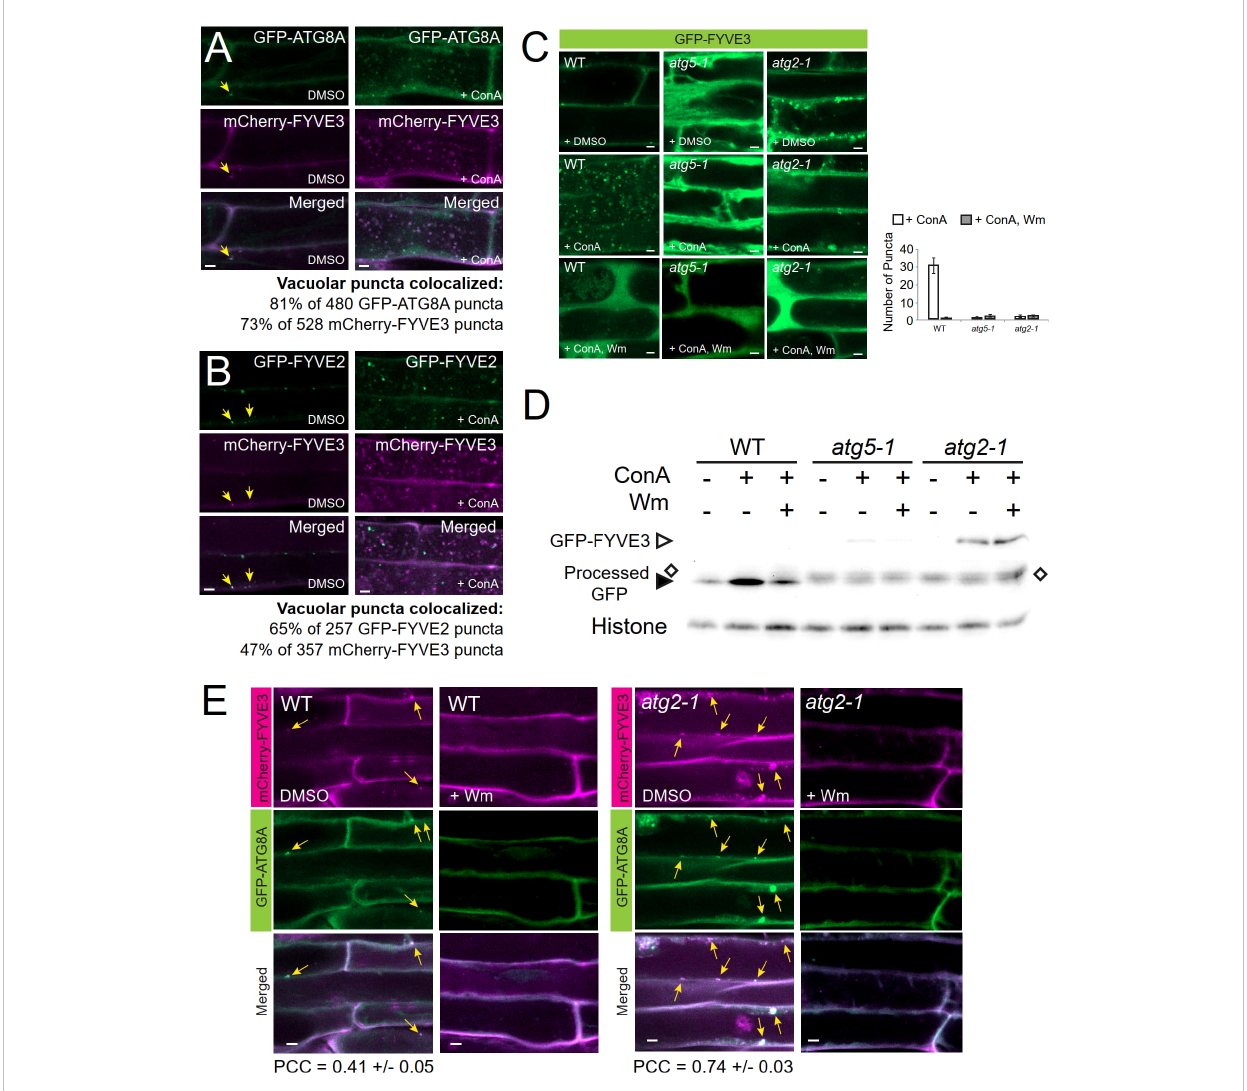
FIGURE 3 Fluorescent fusions of FYVE3 are delivered to the vacuole in a manner dependent on canonical autophagy machinery and PI 3-kinase activity. (A) and (B) , Confocal images of mature root cells co-expressing mCherry-FYVE3 with either GFP-ATG8A (A) or GFP-FYVE2 (B) . Seedlings grown in a nitrogen-rich medium were treated with DMSO or 0.5 µM ConA for 16 h prior to confocal microscopy. In the images of DMSO-treated cells, arrows indicate cytoplasmic puncta showing both GFP and mCherry signal. Percentages of vacuolar bodies showing both GFP and mCherry signal were calculated from ConA-treated cells. (C) , Confocal images of mature root cells expressing GFP-FYVE3 in the genetic background of WT, atg5-1 , and atg2-1 . Transgenic seedlings were incubated in nitrogen-rich liquid medium and treated with DMSO, 0.5 µM ConA, or 0.5 µM ConA plus 30 µM Wm for 16 h. The graph on the right shows the number of vacuolar puncta (mean ± S.E.; n = 12 – 13 images) per 1,000 µm 2 area of the central vacuole. (D) , GFP-FYVE3 cleavage assay. WT, atg5-1 , or atg2-1 seedlings expressing GFP-FYVE3 were incubated as described in (C) , and protein extract was prepared for immunoblot analysis using anti-GFP (upper) and anti-histone H3 (lower; for loading control) antibodies. Open diamonds indicate the position of protein bands that are not stabilized by ConA and migrates slightly slower than free GFP bands (indicated by a solid arrowhead). Representative images selected from 3 repeat experiments are shown. (E) , Confocal images of mature root cells expressing GFP-ATG8A and mCherry-FYVE3 in WT (left images) and atg2-1 (right images) background. Seedlings were incubated in a nitrogen-lacking liquid medium for 48 h and treated with DMSO or 30 µM Wm for 1 h prior to microscopic observation. Arrows indicate GFP-ATG8A puncta overlapping with mCherry- FYVE3 signal. The Pearson correlation coef fi cients (PCCs) were calculated from 10 (WT) and 13 ( atg2-1 ) images (mean ± S.E.). Scale bars = 5